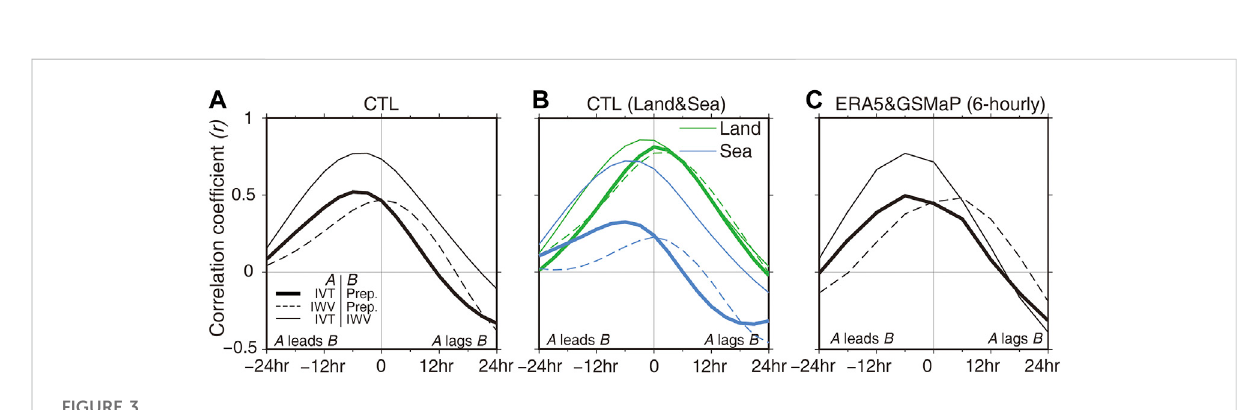
FIGURE 3 (A) Thelead-lagcorrelationsamongthearea-averagedIVT,IWV,andprecipitationduringthestudyperiod(26Juneto13July)overJapan(black box in Figure 1C). (B) represents the coef fi cients calculated over land (green) and sea (blue) areas. Results based on 6-hourly ERA5 and GSMaP are also plotted in (C) for